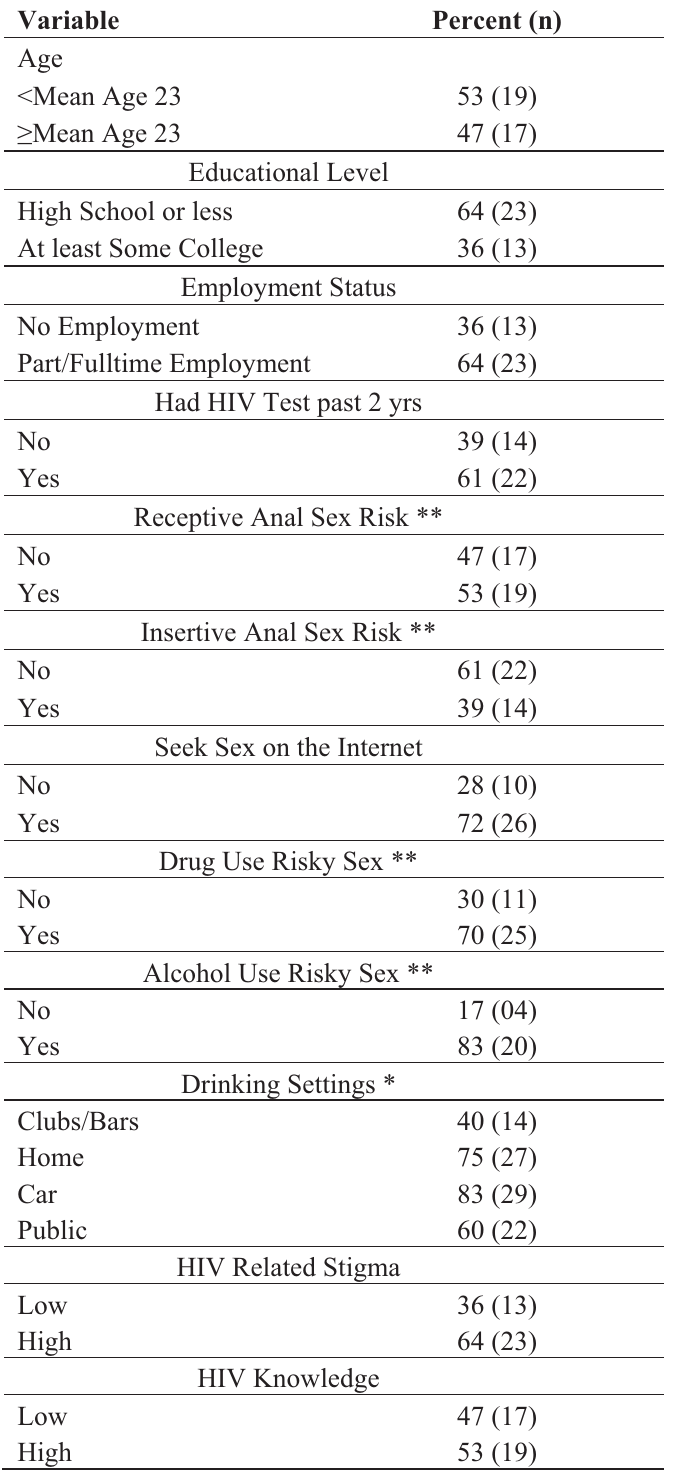
Table 2. Demographic Variables for Study Participants (N =